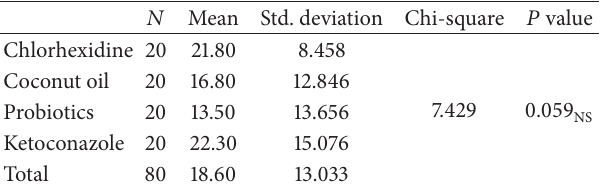
Table 1: Comparison of zone of inhibition between different groups. 𝑁 Mean Std. deviation Chi-square 𝑃 value